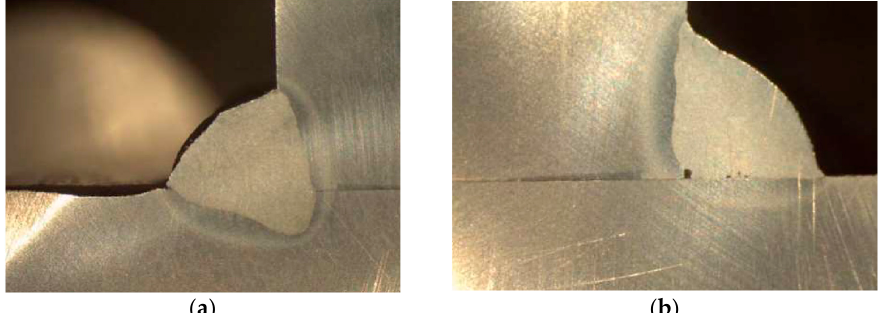
Figure 11. The aspect of convex fillet weld in cross-section: ( a ) good root penetration, and ( b ) incomplete fusion.